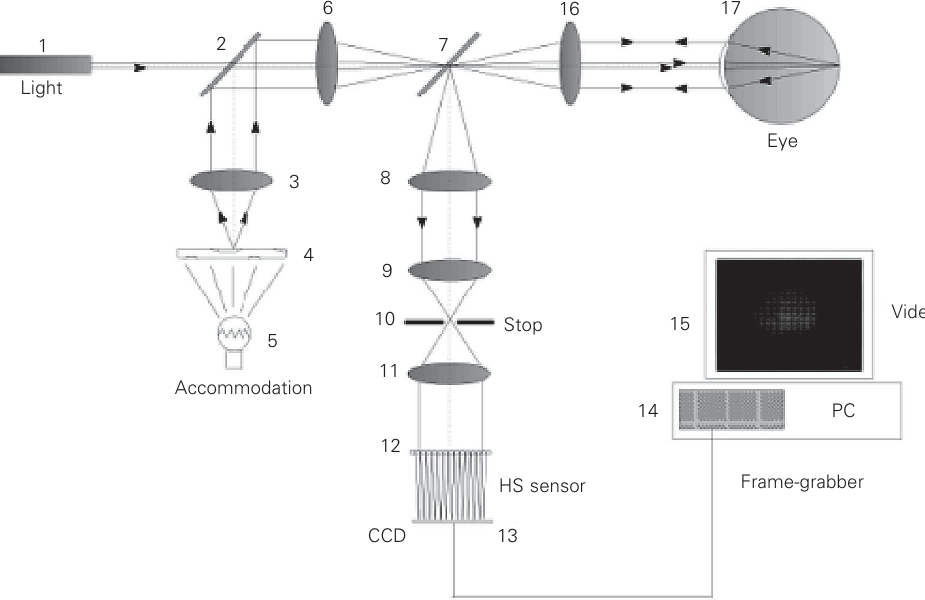
Figure 3. Optical configuration used to measure optical aberrations of the eye. An infrared source [1] with 200 µW is focused towards the eye through spherical lenses [6] and [16]. A filament light source [5] is used to illuminate a light diffuser, which is attached to a reticule containing a balloon picture [4] (this is simply a psychological